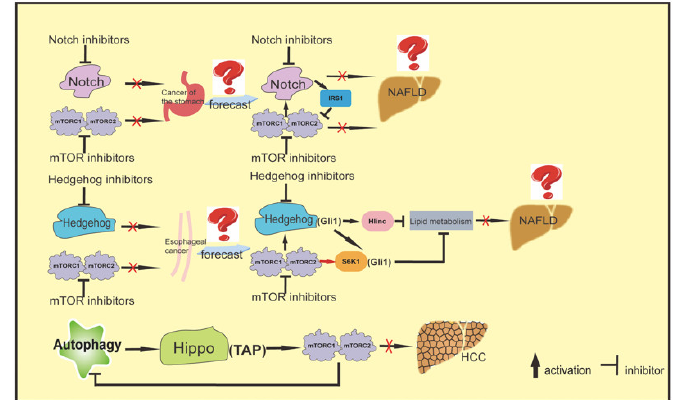
Figure 4. Crosstalk between mTOR and novel pathways: A source of potential new targets for the treatment of NAFLD-associated HCC. (a). Notch and mTOR synergistically promoted gastric cancer cell proliferation, while Notch or mTORC1 combined inhibition inhibited tumor cell growth. Hepatic Notch signaling increases insulin sensitivity by acting on IRS1 and decreases mTORC1-mediated SREBP-1c activity and hepatic triglycerides. However, the role of Notch and mTOR crosstalk in NAFLD remains unclear. The combination of (b). mTOR pathway inhibitors and Hedgehog pathway inhibitors inhibited esophageal cancer cells by up to 90%. The Hedgehog signaling pathway directly regulates Hilnc (Hedgehog signaling induced long non-coding Rnas) that participates in mTOR regulated liver lipid metabolism. Gli1 is identified as the substrate of S6K1, providing a Gli1 activation mechanism between mTOR and Hedgehog signaling pathways that is not dependent on Smoothened, a G-coupled receptor-like signal sensor. Therefore, it is speculated that crosstalk be- tween the mTOR and Hedgehog signaling pathways can regulate NAFLD and even HCC through lipid metabolism. (c). YAP has a positive control effect on both mTORC1 and mTORC2, and the YAP protein can inhibit the initiation of autophagy and affect the progress of HCC by activating the mTORC1 signaling pathway, suggesting that the mTOR signaling pathway and Hippo pathway are crosstalk regulating HCC. 11. Discussion mTOR has received much attention since its discovery. Because mTOR is closely re- lated to biological activities, not only in the liver as described in this paper but also in fat, skeletal muscle, brain, gastrointestinal and other organs, mTOR-targeted inhibitors have been studied. However, at present, the main therapeutic application of mTOR is in cancer, especially focused on the classic PI3K/AKT/mTOR signaling pathway, implicated in can- cer, which has been widely studied to develop treatments for cancer. However, the focus on the development of cancer therapeutics has come at the cost of adequate research on metabolic diseases and other pathologies. There is currently a lack of systematic elucida- tion of the relationship between mTOR and metabolic diseases, such as NAFLD; thus, this review aims to provide an update on research on NAFLD in metabolic diseases and ad- vocates for a shift in research attention to address the crucial need for more research and development of mTOR inhibitors for application in metabolic diseases. This review can not only solve the early noninvasive diagnostic indicators and clini- cal future targets so as to provide a certain reference basis, but also sheds light on the molecular mechanism by means of macro and micro clear concrete mechanisms and the effect of the mTOR NAFLD, summed up in the form of a table (Table 1), and mTOR sig- naling pathways/mechanism of NAFLD stages and the influence of the development pro- cess. The effect of crosstalk between mTOR and novel pathways on the treatment of non- alcoholic fatty liver-related hepatocellular carcinoma is also of great significance for the treatment of NAFLD-related hepatocellular carcinoma in the future, which may provide a reference for the development of new mTOR inhibitors. According to the table (Table 1) and the above explanation, we can also find that there are many factors affecting the de- velopment of NAFLD, but most of them focus on the signaling pathways such as